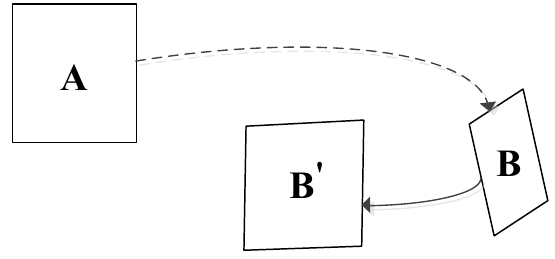
Fig.1 Schematic diagram of ASIFT method (Morel et al., 2009)